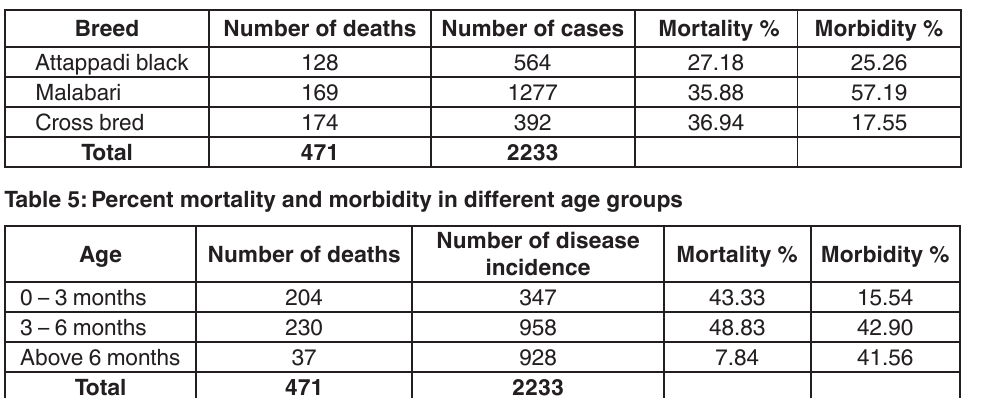
Table 4: Percent mortality and morbidity in different breeds Breed